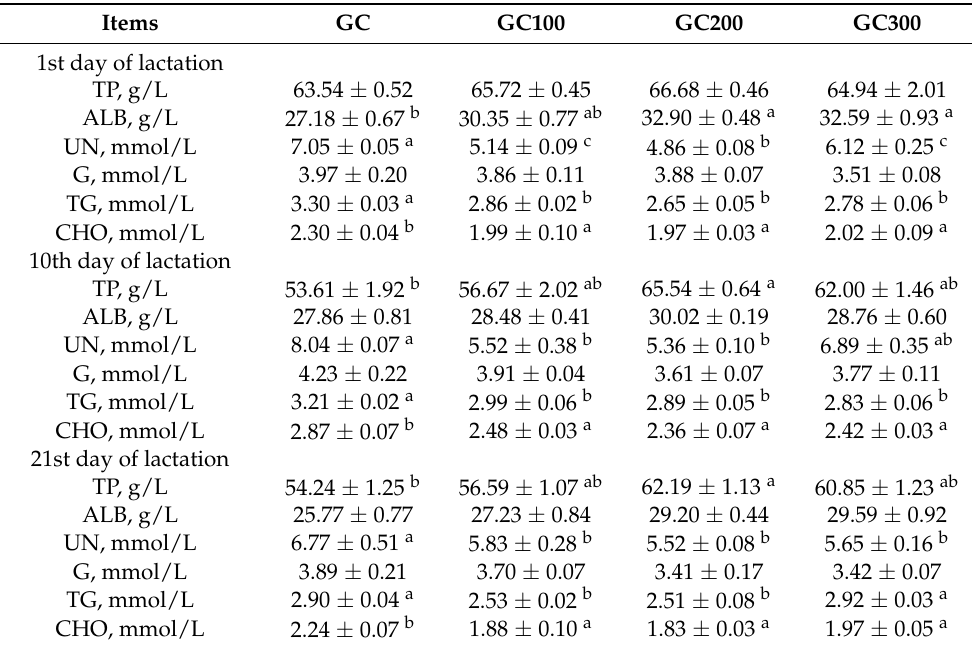
Table 4. Effects of SI and APS mixture on serum antioxidant and other indexes of lactating sows.